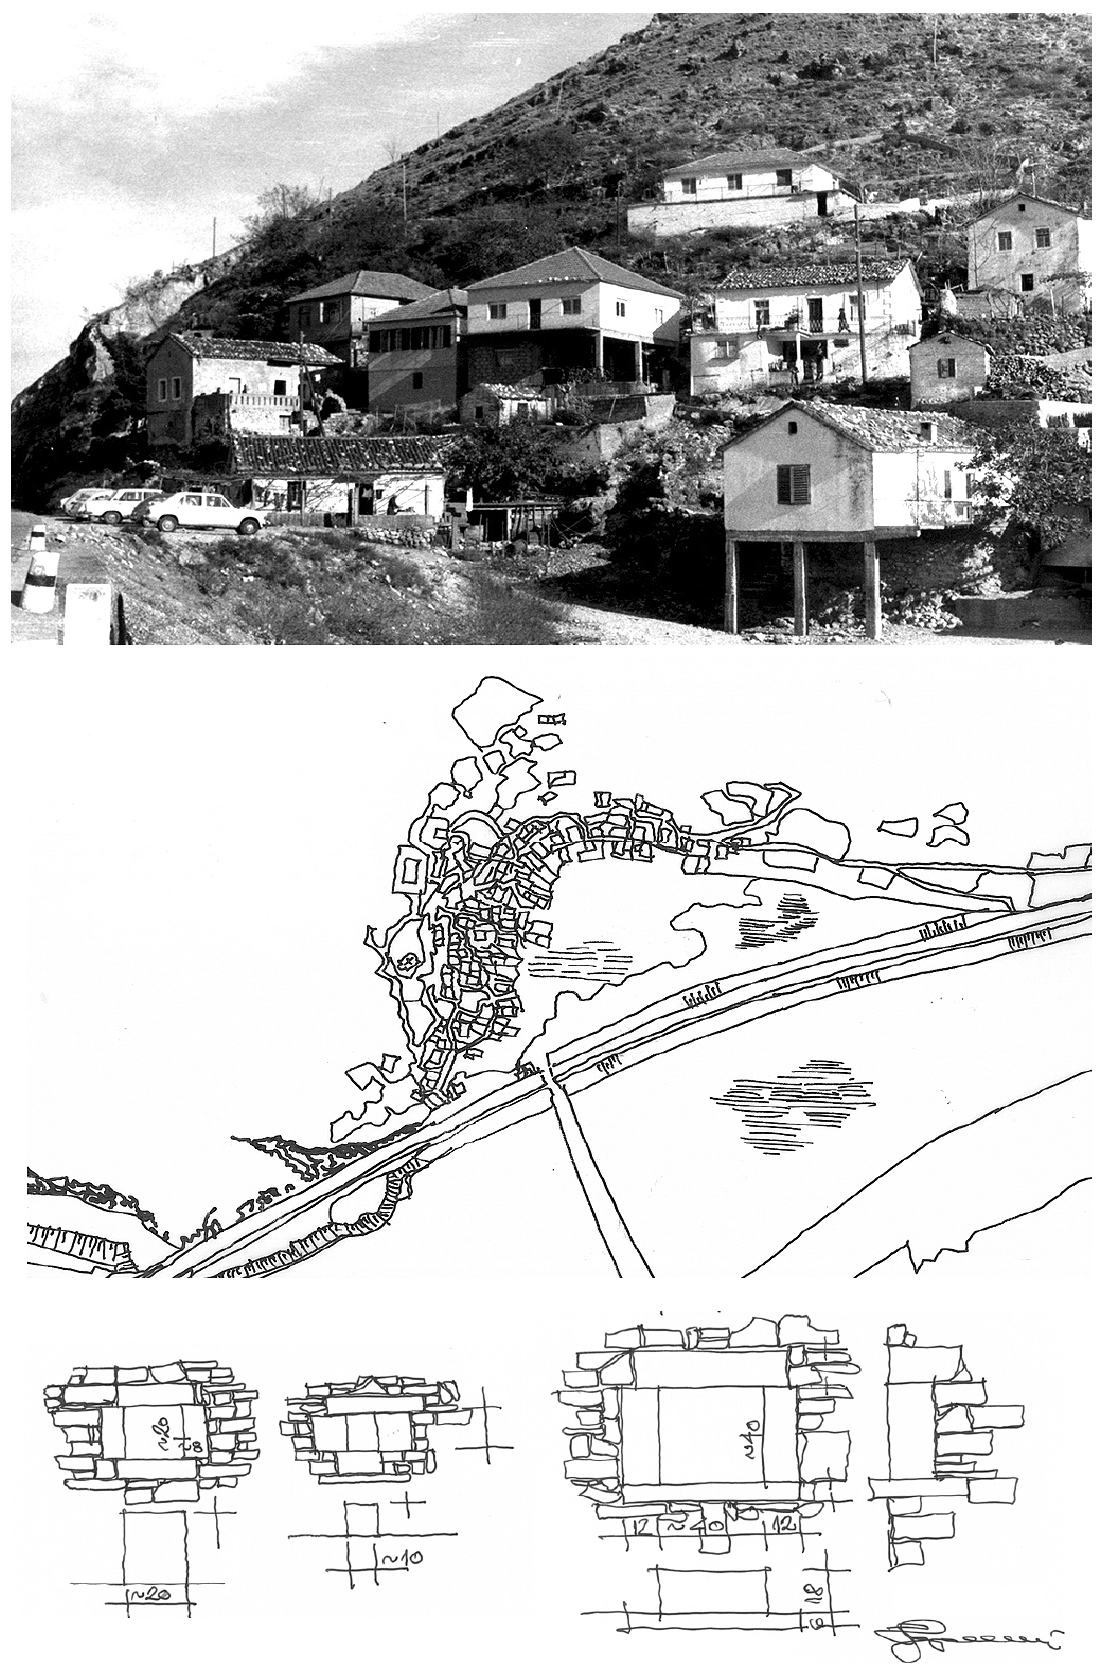
Figure 20. Photo and drawing of Vranjina settlement, Zeta region (S. G. Popovic).